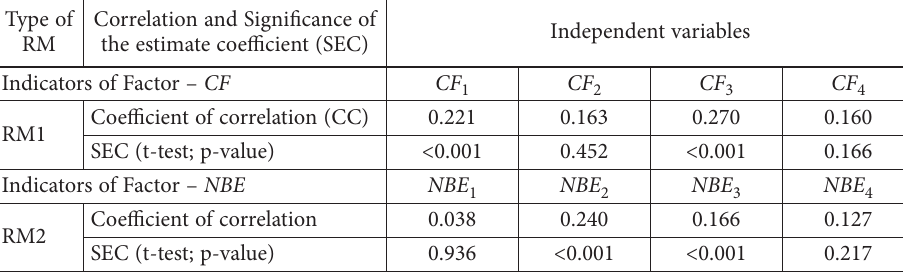
Table 2. Correlation and SEC according to the selected model (source: own data collection) Type of RM